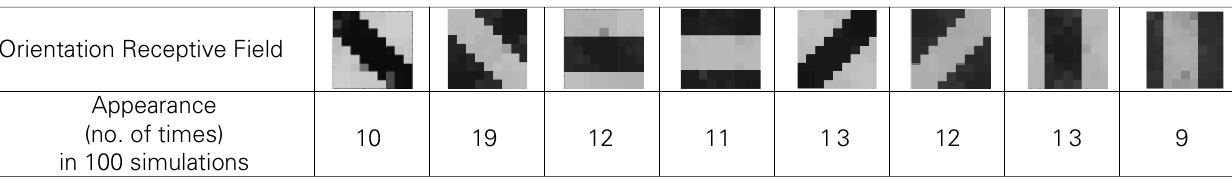
Table 1B | Analysis of 100 simulations.